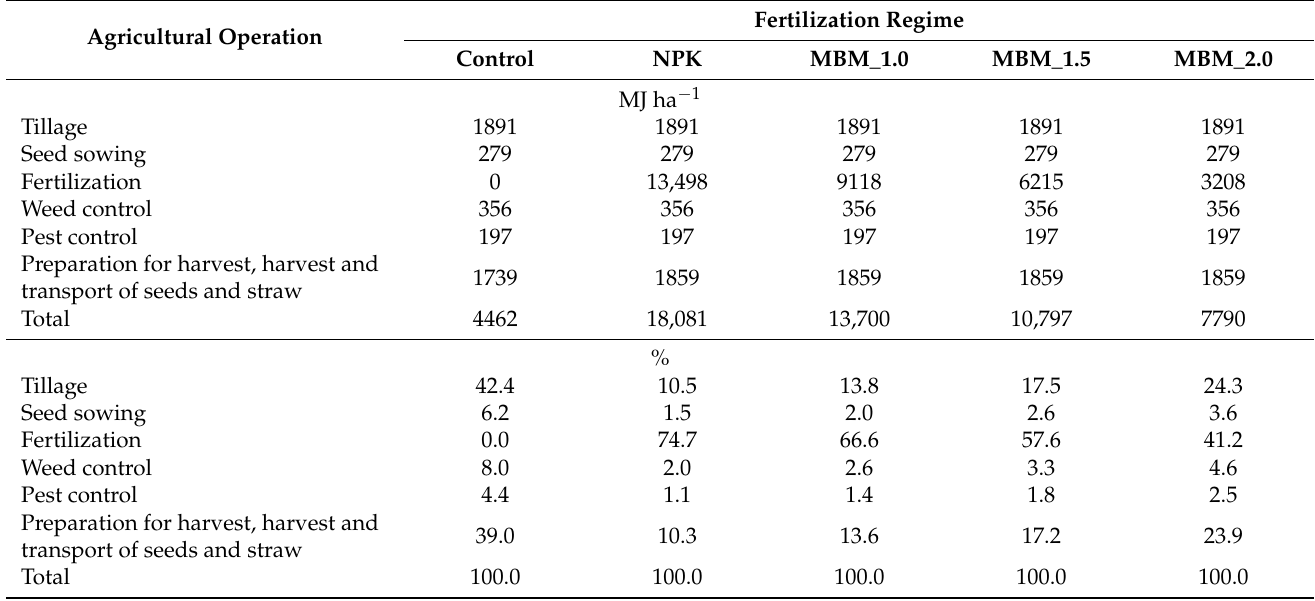
Table 5. Energy inputs associated with the production of winter oilseed rape per agricultural operation (across years).